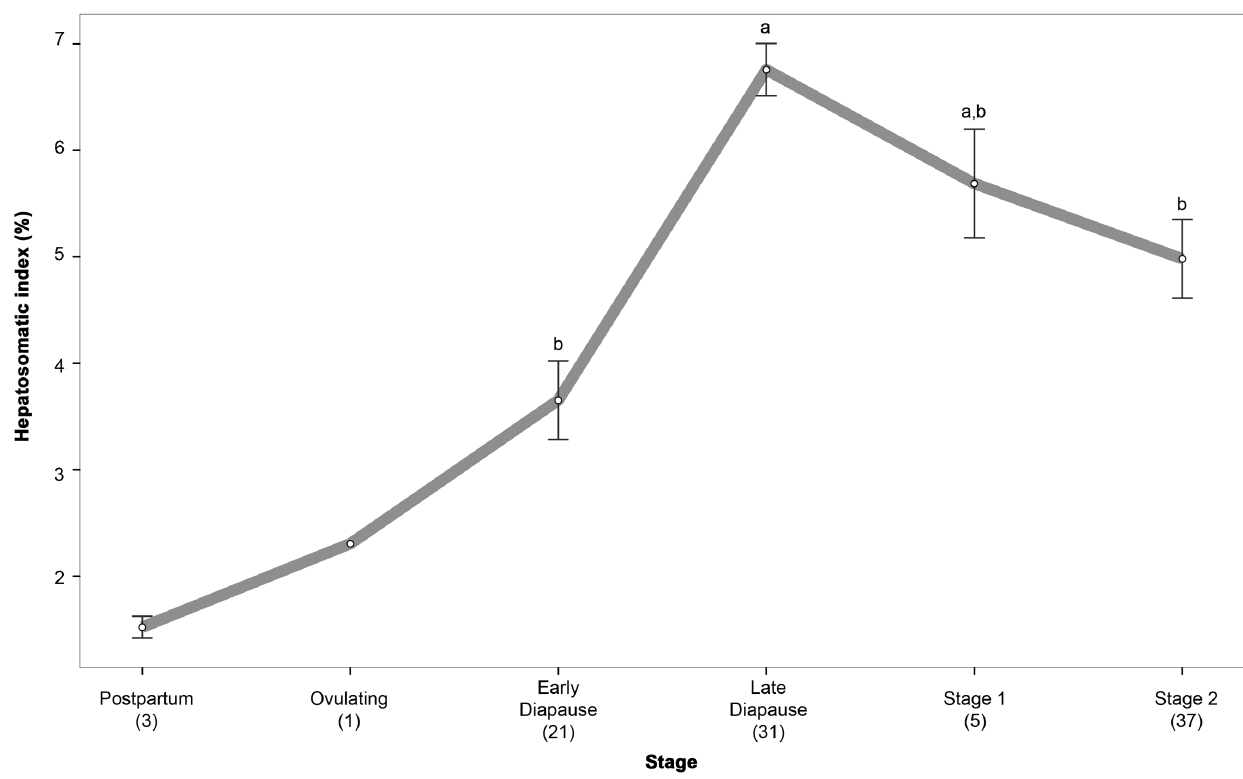
Figure 2. Hepatosomatic index variation throughout reproductive cycle in female Rhizoprionodontaylori . Values are medians 6 SE. Letters depict statistical similarity using pairwise Wilcox post-hoc test. Missing letters represent groups that are too small for statistical analysis. Numbers in brackets denote sample size.